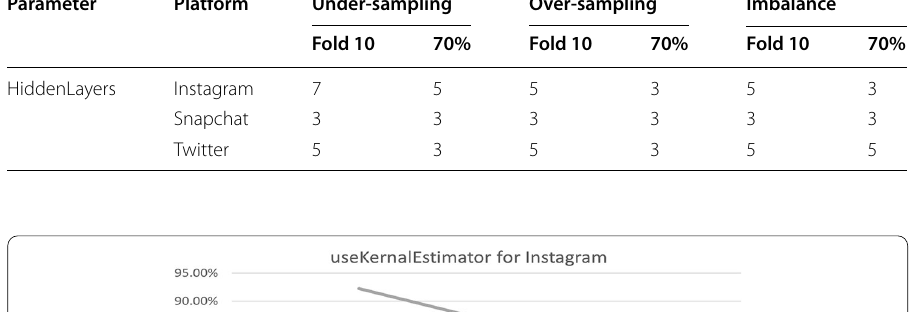
Table 5 Optimal parameter for MLP model Parameter